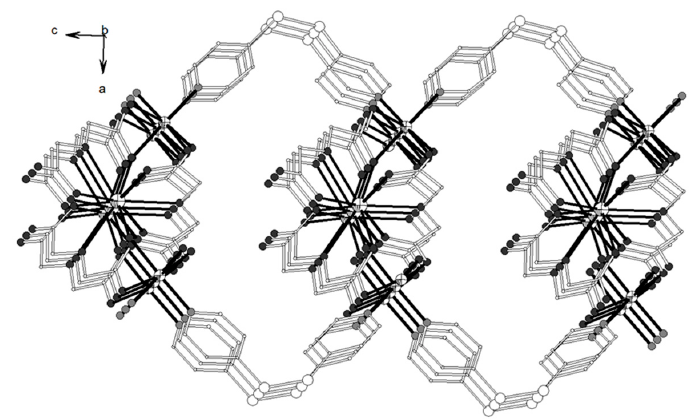
Figure 23. Part of the 2D layer structure of 179 . Color code: Eu large octant, Ni small octant, N light grey, O dark grey, C open small, S open large